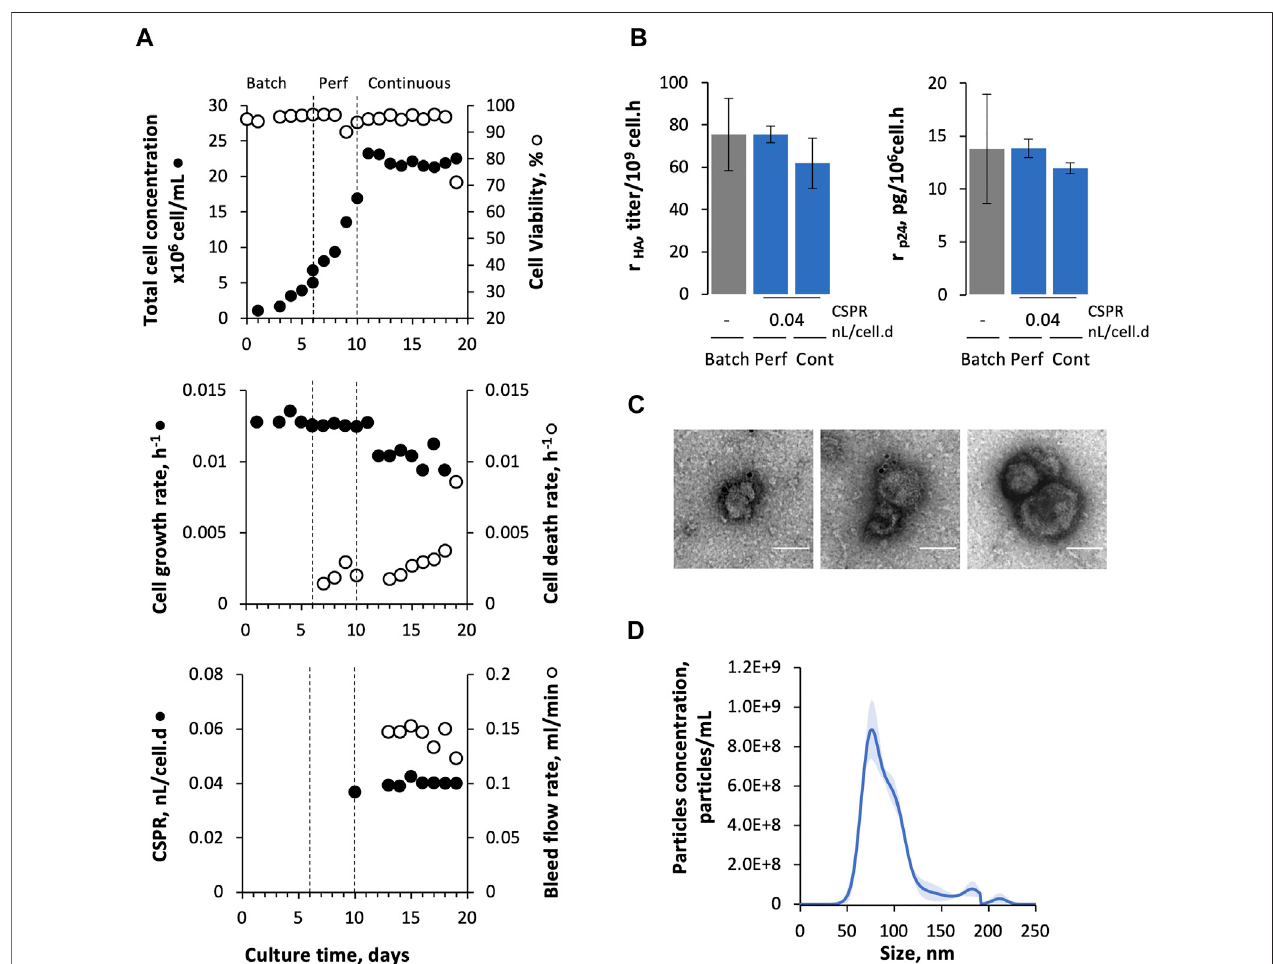
FIGURE 2 | Production of Gag-HA VLPs in continuous operation mode using TFF. (A) Cell growth and viability kinetics, cell growth and death rate, cell-speci fi c perfusion rate (CSPR), and bleed fl ow rate. (B) Speci fi c HA and p24 production at different modes of operation (batch, perfusion, and continuous). (C) Immunogold staining TEM and (D) nanoparticle tracking analysis from puri fi ed and concentrated Gag-HA VLP samples. Data in bar graphs are expressed as mean ± SD of one biological replicate using data linearization. One-way ANOVA with post-hoc Tukey ’ s multiple comparison analysis method. The mean of each column was compared with the mean of the batch; * adjusted p -value < 0.05 was considered statistically signi fi